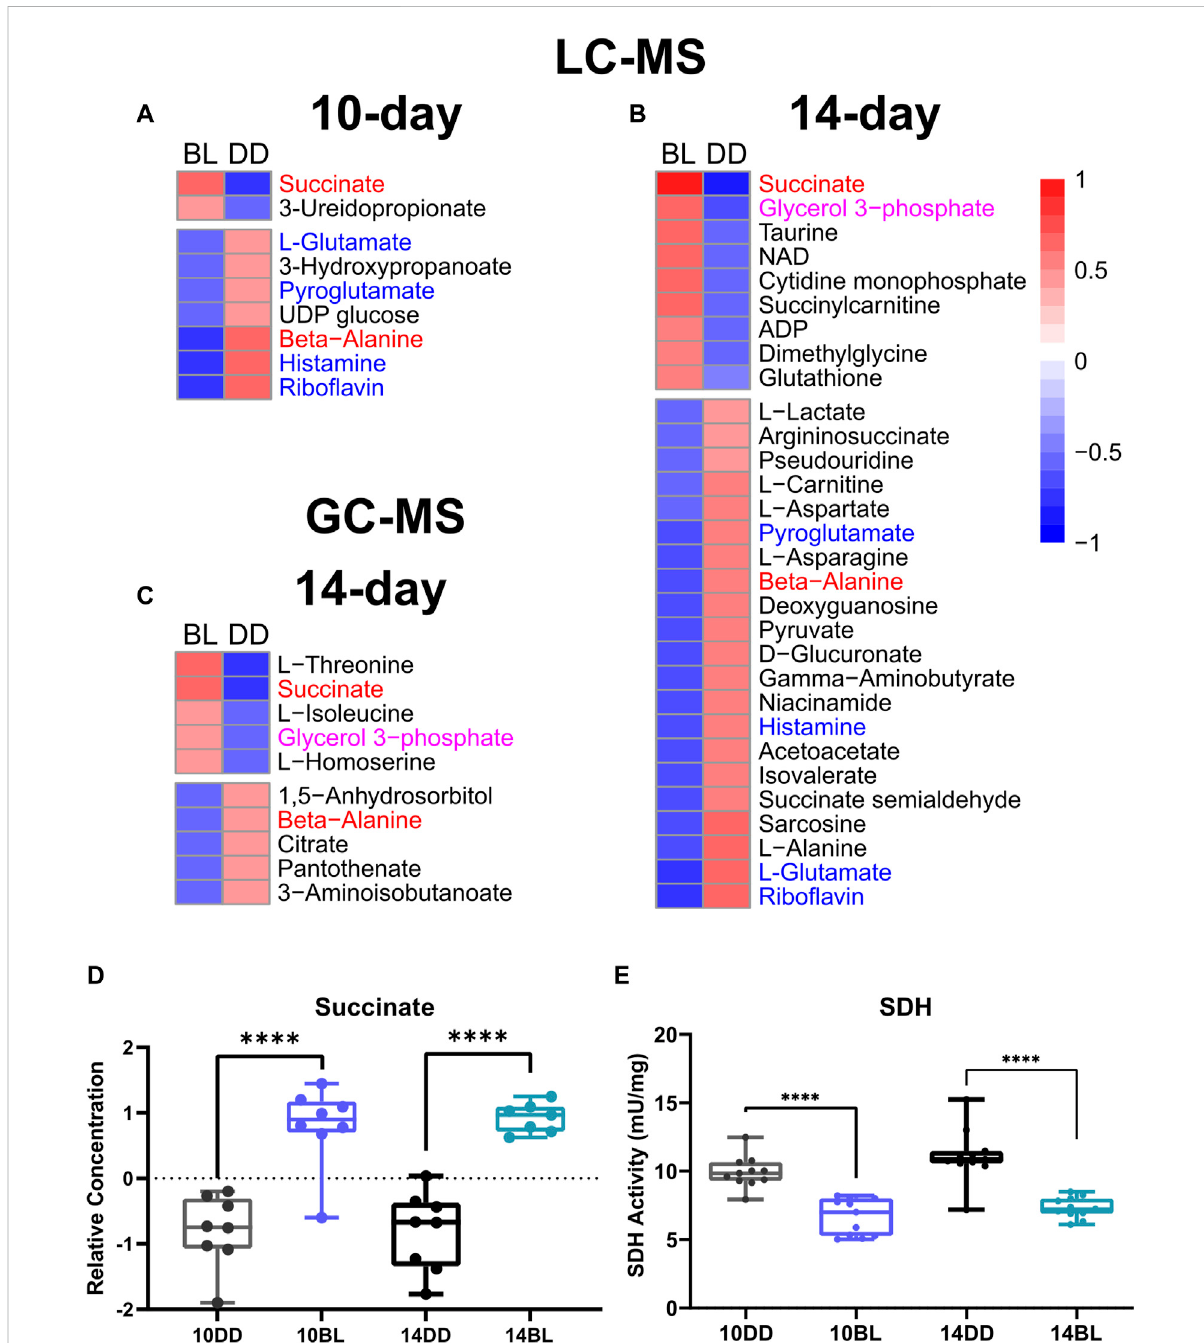
FIGURE 3 Heatmapsshowingmetabolitessigni fi cantlyalteredinresponsetoBL. (A) BLexposurefor10 dayswithdetectionbyLC-MS. (B) BLexposurefor 14 days with detection by LC-MS. (C) BL exposure for 14 days with detection by GC-MS. Labels in red denote metabolites found signi fi cant by both methods at both time points, labels in blue show metabolites found signi fi cant by LC-MS after both 10 and 14 days of BL exposure, and labels in purple show metabolites found signi fi cant after 14 days of BL exposure with both methods. (D) Relative concentrations of succinate the most signi fi cantly altered metabolite. (E) Activity of succinate dehydrogenase (SDH) measured in heads of eya 2 fl ies was signi fi cantly altered after 10 and 14 days of BL exposure. Lines in box plot represent max, upper quartile, median, lower quartile, and min from top to bottom. Statistical analysis by unpaired t -test ( pppp p <